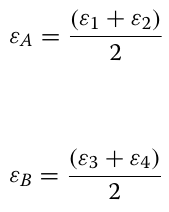
where F A and F B are the forces of the eye bars A and B, respectively; E and A are the elastic modulus and the cross-sectional area of the bars, respectively ( E A 1129 mm 2 ); and ε A and ε B are the axial strains of the A and B bars, respectively. Con- = sidering the strain reading scheme ( ε 1 through ε 4 ) given in Fig. 2(c),